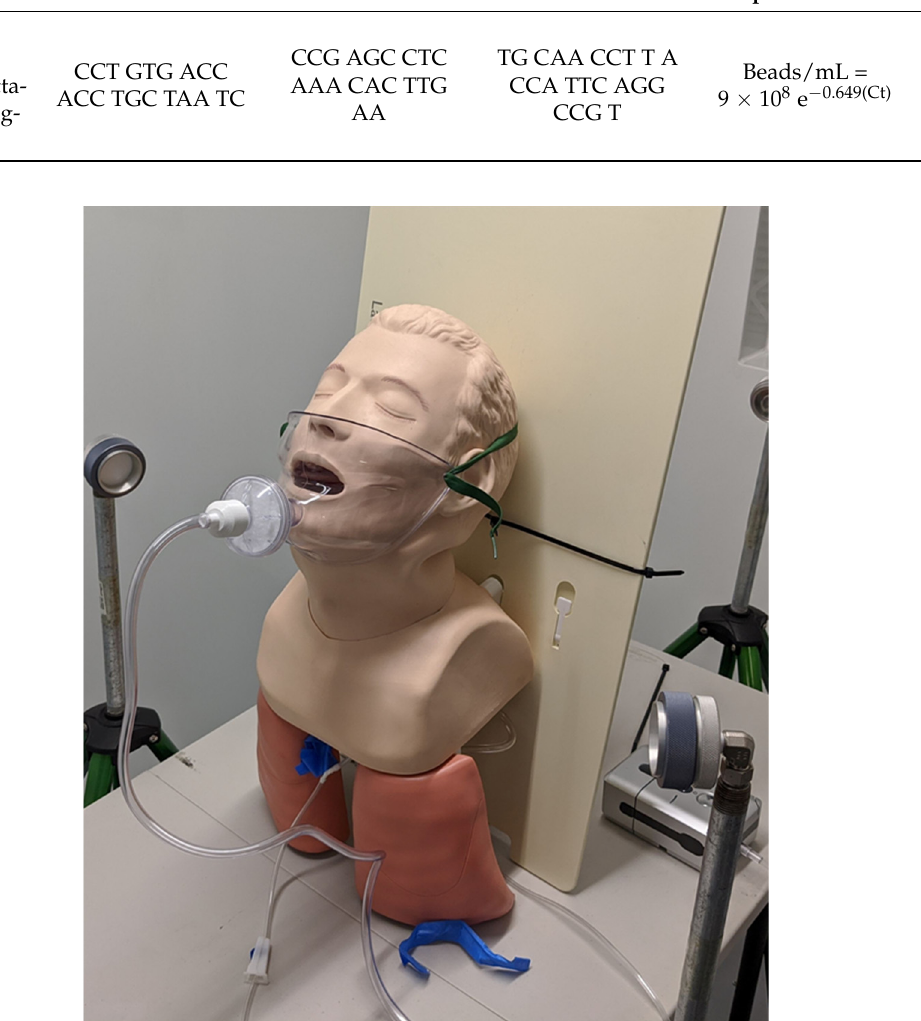
Figure 2. Photograph of the experimental arrangement used in preliminary evaluation of the IACM. A schematic drawing is available in the Supplementary Materials (Figure S3).